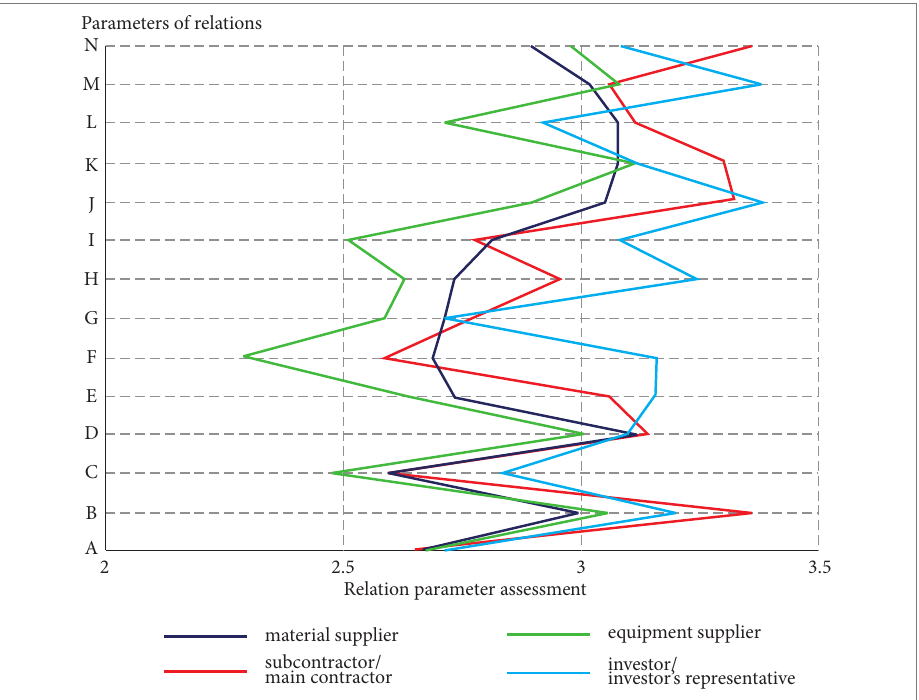
Fig. 4. The assessment profiles of the parameters of relations between Ukrainian construction enterprises and four